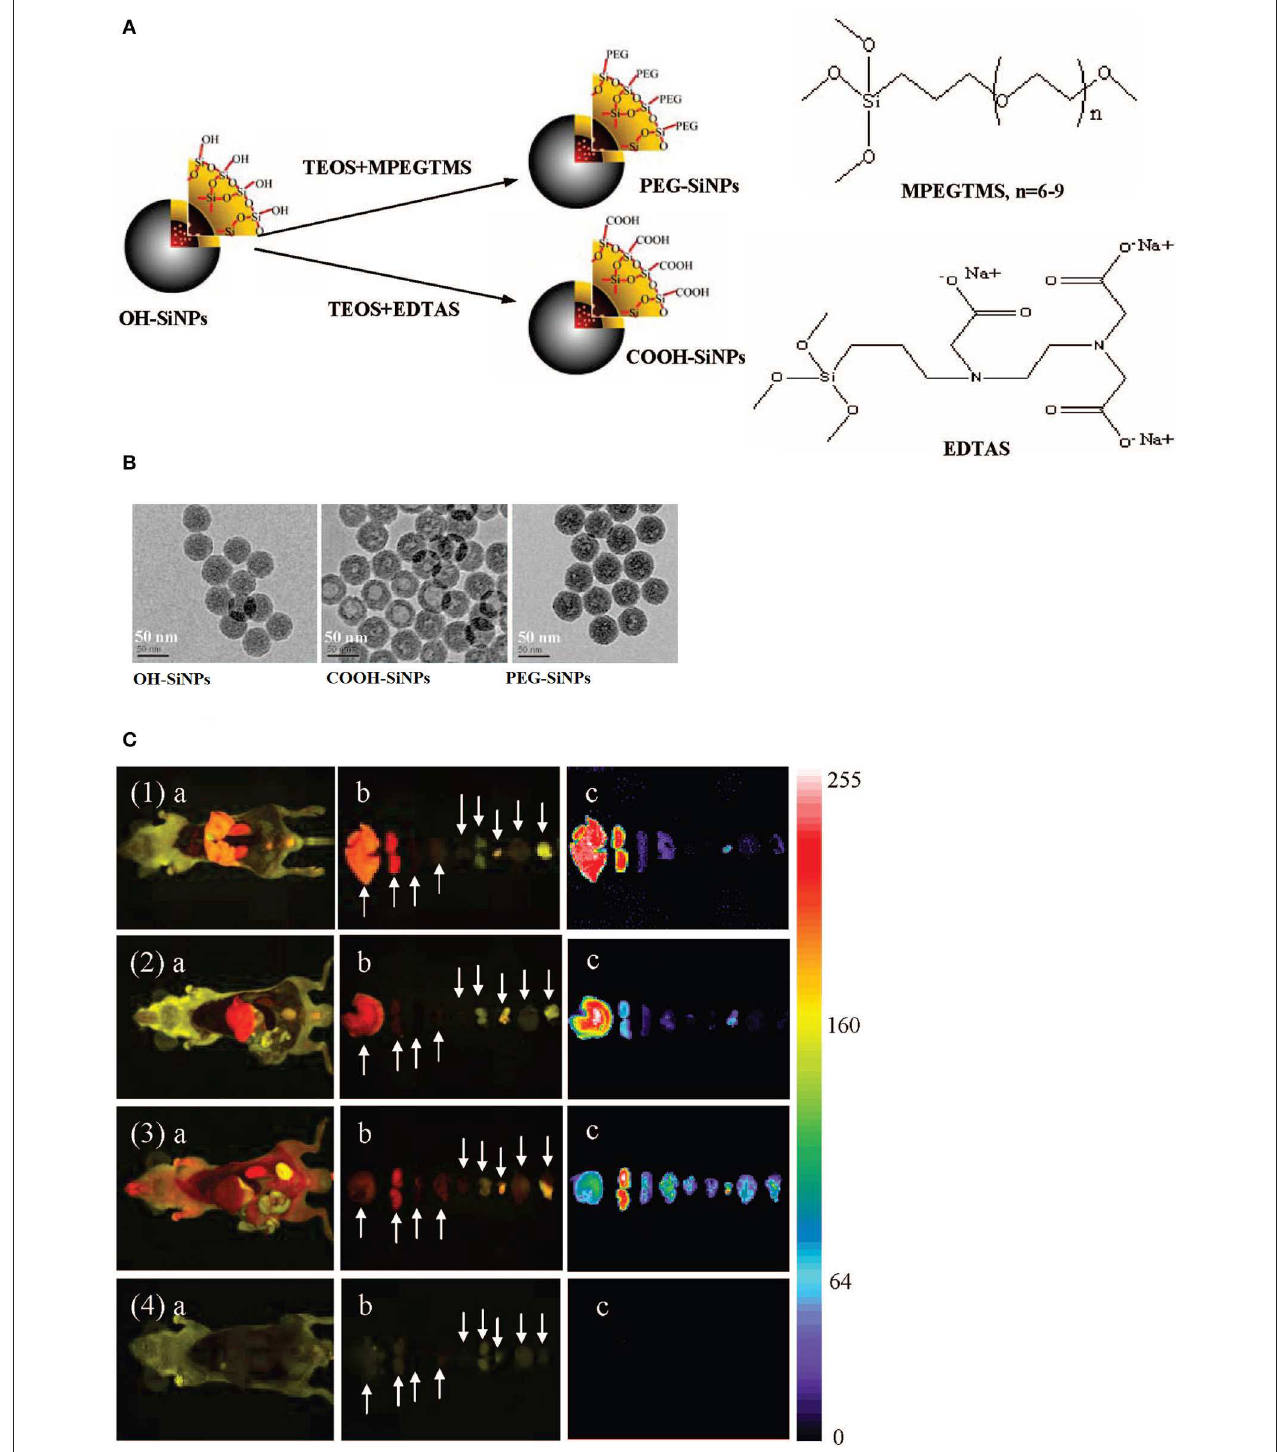
FIGURE 5 | Illustration (A) and TEM images (B) of three silica surface functionalized nanomaterials. (C) Ex vivo imaging of mice after intravenous injection, with various organs throughout necropsy after 4.5h, for treated mice (1) OH–SiNPs, (2) COOH–SiNPs; (3) PEG–SiNPs and untreated mice (4). Arrows represent from left to right: liver, kidney, spleen, lung, heart, spermary, bladder, brain, and muscle. Reproduced with permission He et al. (2008) Copyright 2008, American Chemical Society.